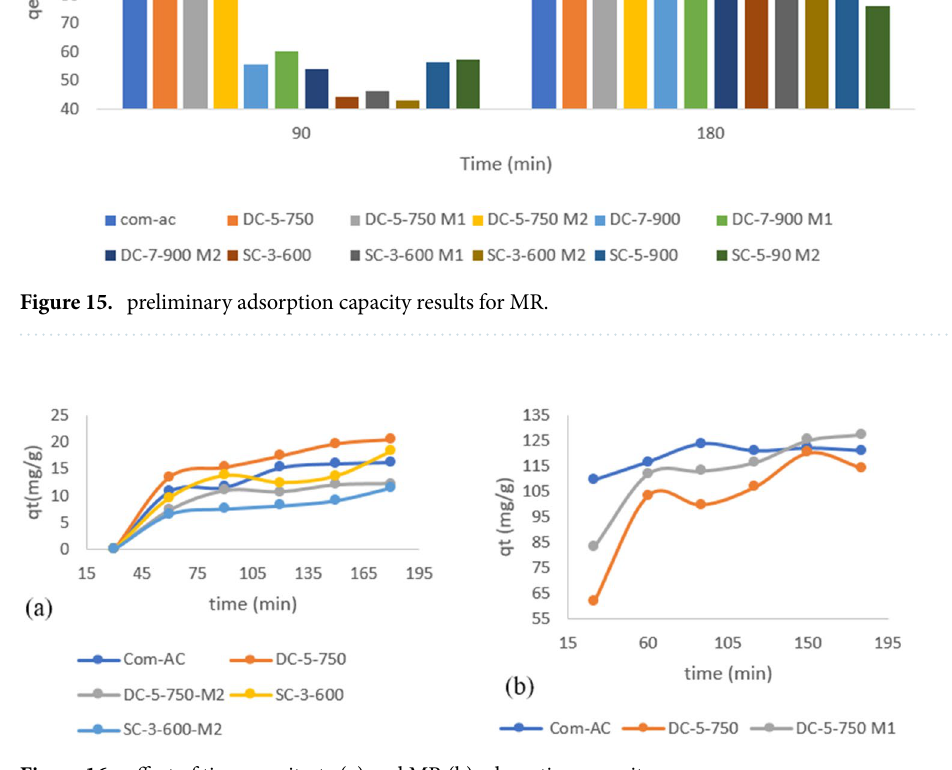
Figure 16. effect of time on nitrate ( a ) and MR (b) adsorption